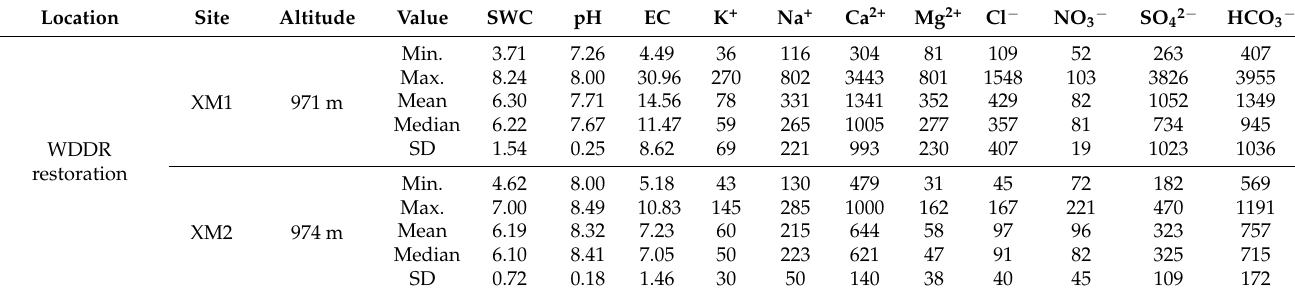
Table 1. Statistical summary of pH, EC values and ion concentrations of soil-soluble salt in the study area (the unit of EC is mS/cm, the unit of soil water content is %, and the unit of ion concentration is